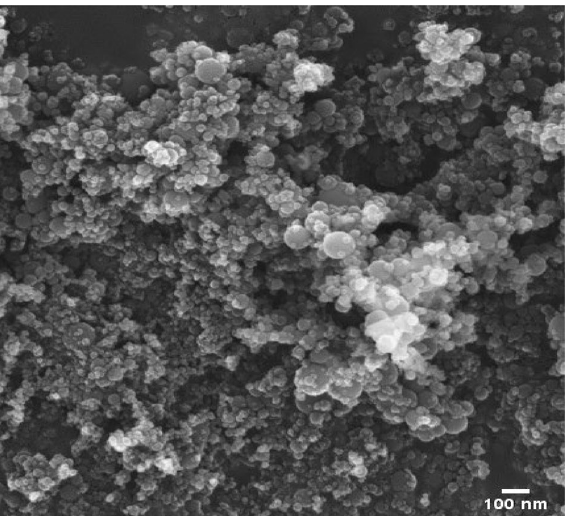
Figure 1. Aluminium oxide nano particles.